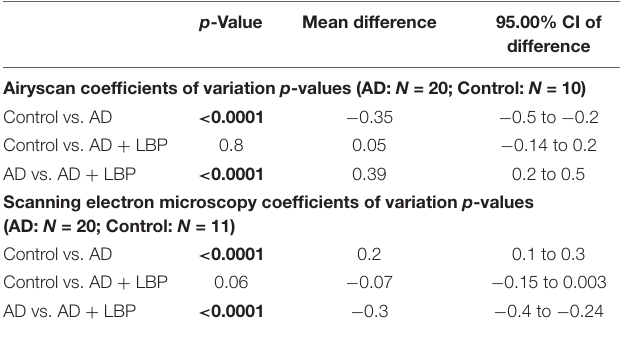
TABLE 2 | Data for Alzheimer-type dementia and healthy individuals showing the coefficients of variation (CV) of the intensity of the pixels in the clot images (Tukey’s analysis).